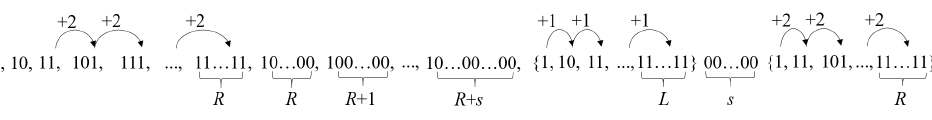
Figure 5: The pre-computation of CWM by binary form.